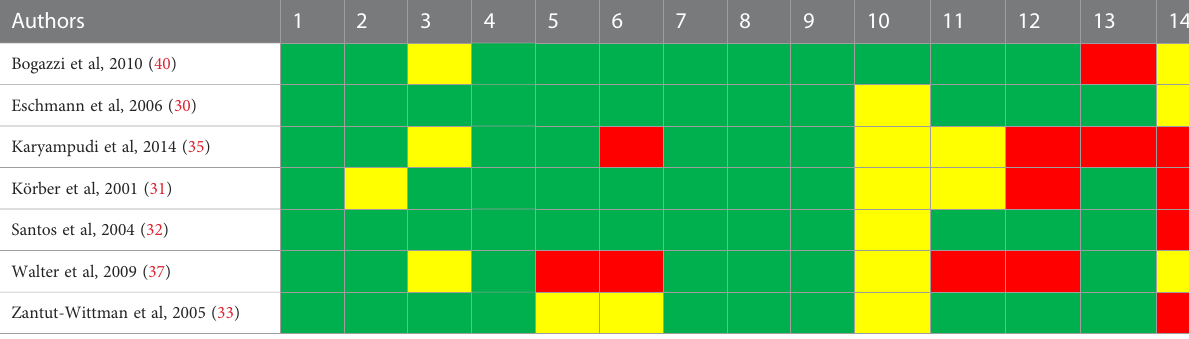
Red indicates high risk of bias, yellow indicates unclear risk of bias and green indicates low risk of bias. Questions in checklist are: 1. Did the study address a clearly focused research question? 2. Was the cohort recruited in an acceptable way? 3. Was the exposure accurately measured to minimize bias? 4. Was the outcome accurately measured to minimize bias? 5. Have the authors identi fi ed all important confounding factors? 6. Have they taken account of the confounding factors in the design and/or analysis? 7. Was the follow up of subjects complete enough? 8. Wasthe followup ofsubjects long enough? 9. Whatare the resultsofthis study? 10.How precise are the results?11. Doyou believe the results? 12.Can the